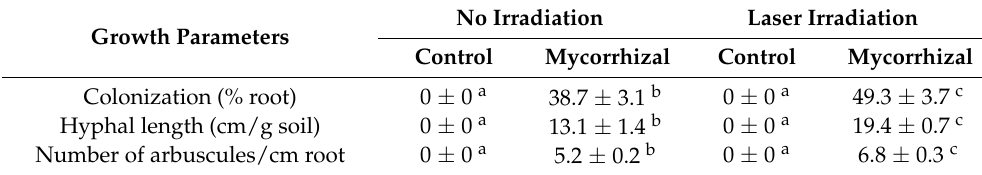
Table 1. Effect of irradiation and mycorrhizal inoculation on growth parameters.